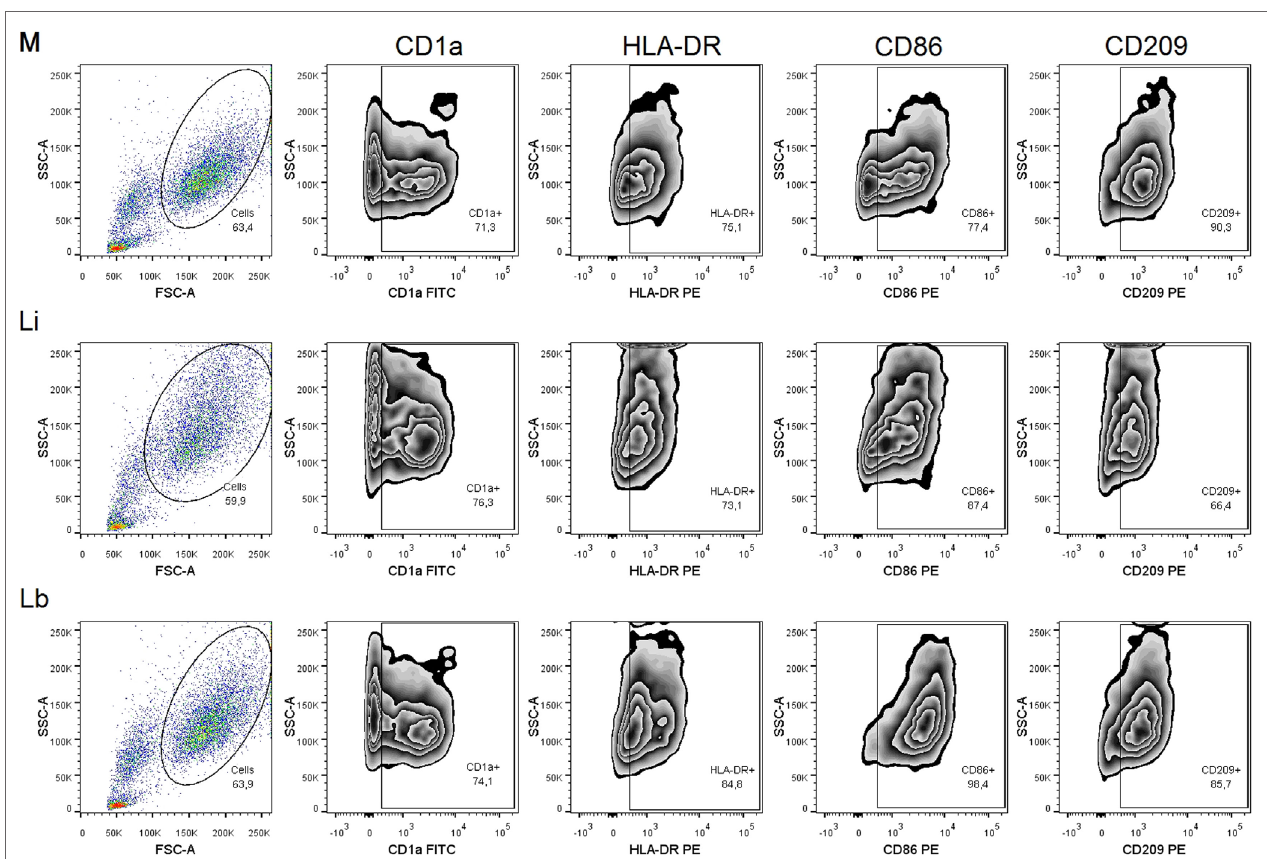
FigUre 2 | gating strategy to analyze Dcs’ regulation by Leishmania parasites – Dcs in control and infected conditions were gated by granularity and size and further analyzed for expression of cD1a/hla-Dr/cD86/cD209 surface molecules . M, medium, Li, Leishmania infantum , Lb, Leishmania braziliensis